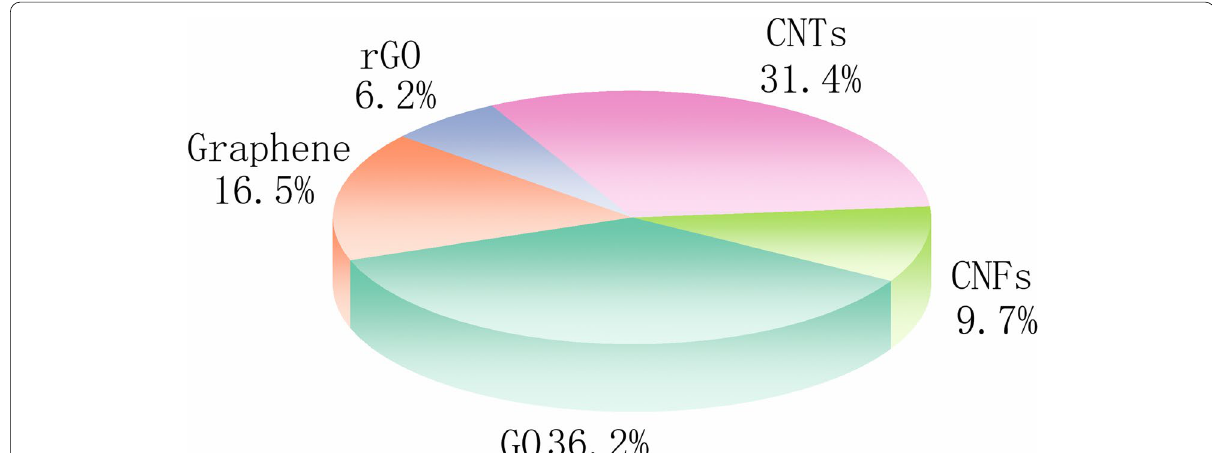
Fig. 3 The relative number of published articles of various CNMs used for manufacturing cement composites, rGO is reduced GO. (Data collected from Google Scholar from 2011 to 2021, total of 14206 published literature)